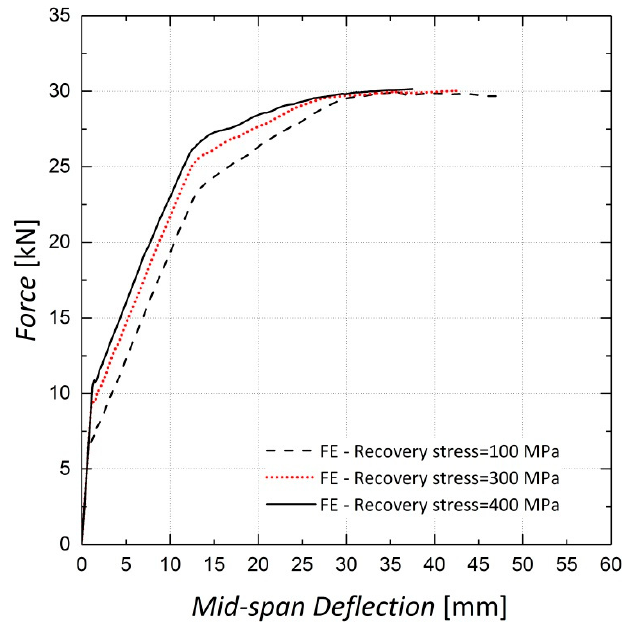
Figure 22. Load–deflection results—steel rebar diameter of 12 mm.